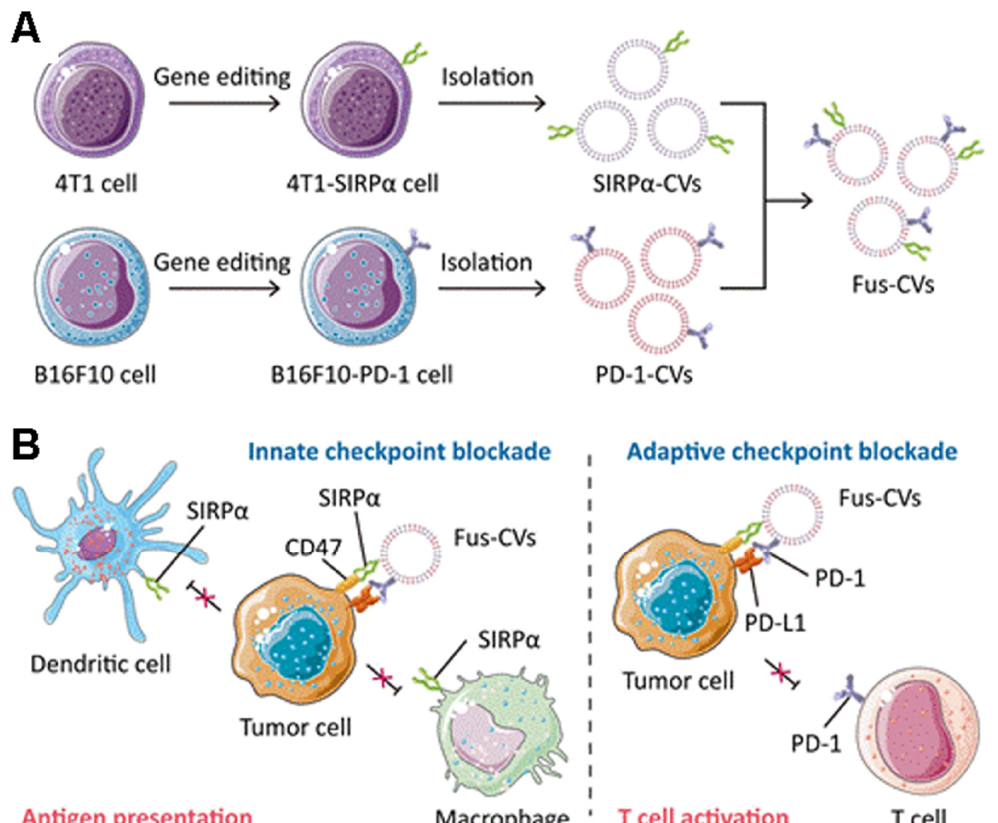
Figure 4. Gene-edited fusion vesicles for multi-targeted immune checkpoint therapy. ( A ) SIRP α variants CV1 and PD-1 were overexpressed on 4T1 and B16F10 cancer cells, respectively, and fusion vesicles were then prepared. ( B ) Fusion vesicles promote antigen uptake and presentation by antigen-presenting cells and enhance anti-tumor T-cell immunity by blocking CD47/SIRP α and PD-1/PD-L1immunosuppressive axis. Reproduced with permission [73]. Copyright 2021, Wiley-VCH.